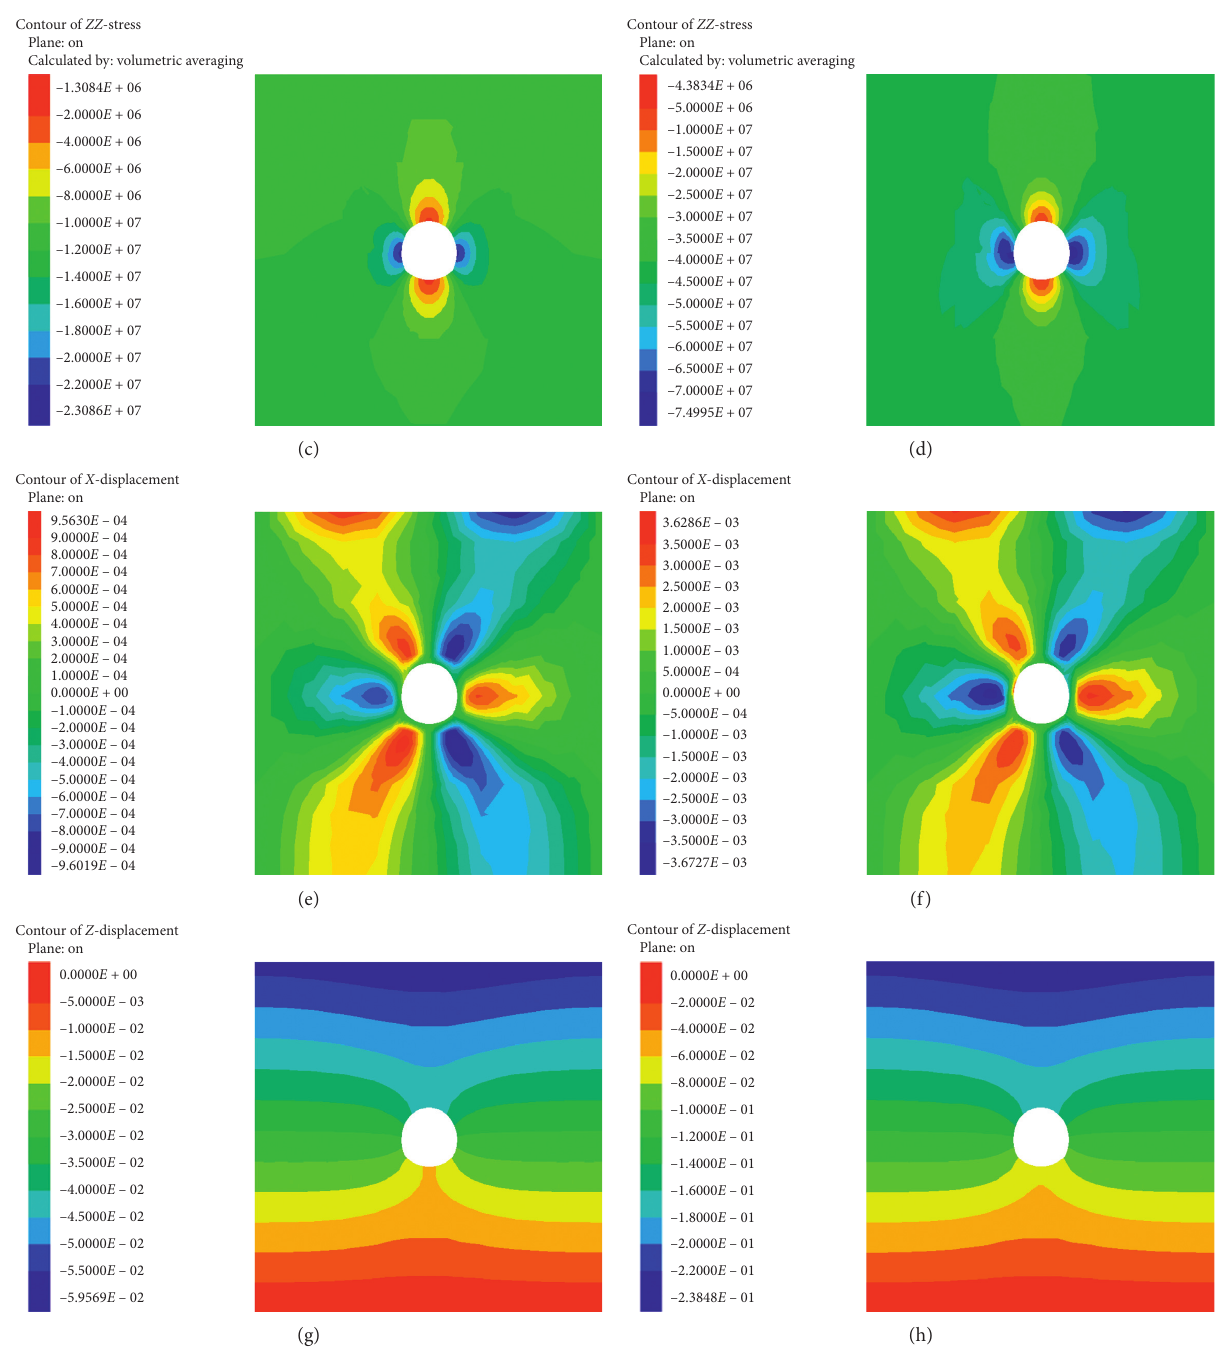
Figure 3: Simulation of the effect of tectonic stress on the tunnel. (a) Distribution of vertical stress ( P � 20MPa). (b) Distribution of vertical stress ( P � 40 MPa). (c) Distribution of horizontal stress ( P � 10MPa). (d) Distribution of horizontal stress ( P � 20MPa). (e) Distribution of horizontal strain ( P � 20MPa). (f) Distribution of horizontal strain ( P � 40MPa). (g) Distribution of vertical strain ( P � 10MPa). (h) Distribution of vertical strain ( P � 20